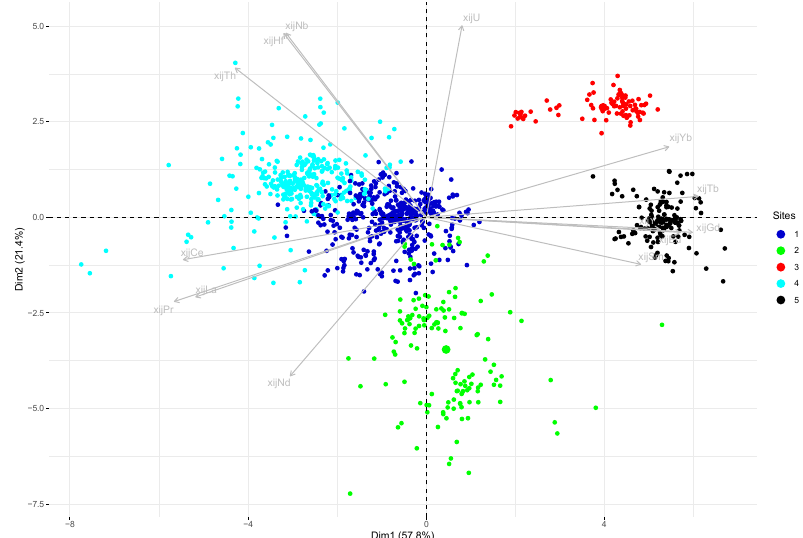
Figure 8. Results of a Hierarchical Agglomerative Clustering (HAC) (Ward’s method) considering 5 clusters, plotted on the PCA/PC2 projections of the PCA analysis.